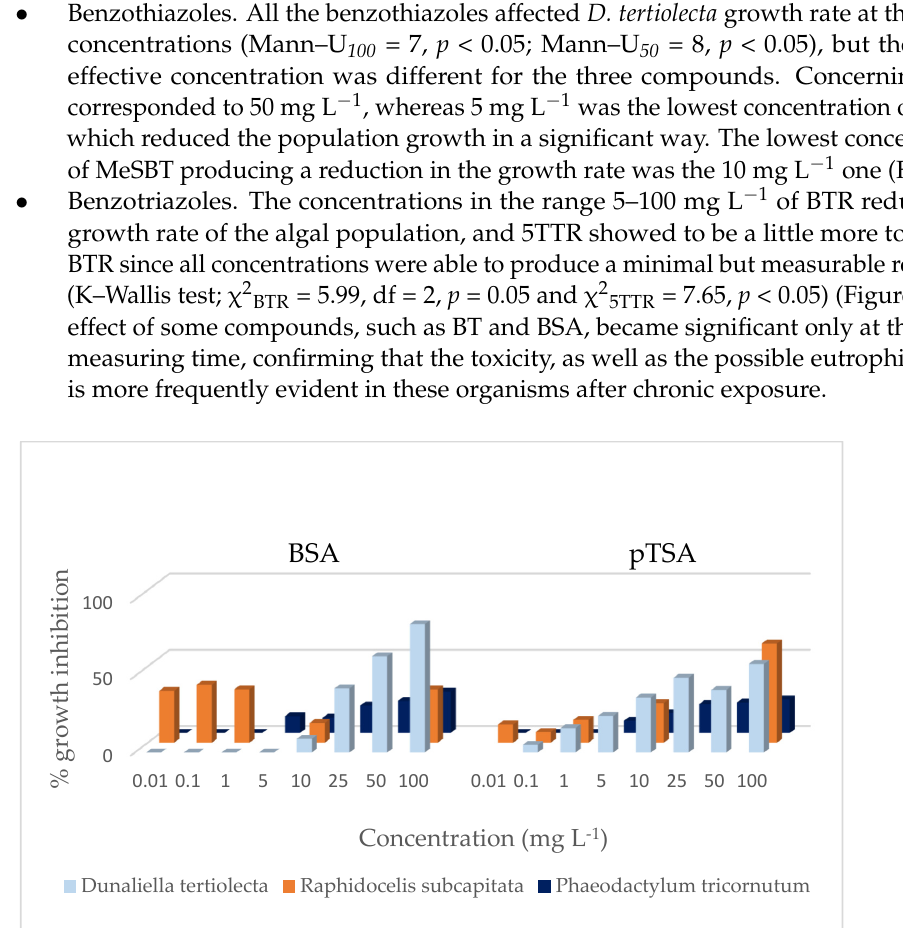
Figure 4. Values of the percentage of growth inhibition produced by the three benzothiazoles on the three algal species.